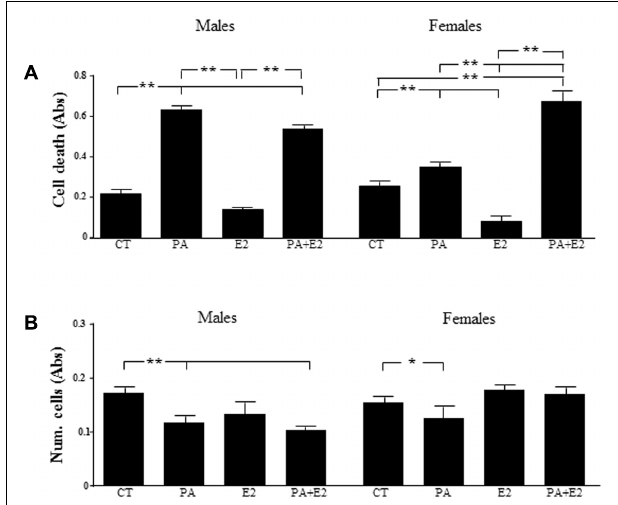
FIGURE 5 | Effects of PA and 17 β E2 on cell death and cell viability. Astrocyte cultures were treated with PA (0.5 mM), E2 (10 − 10 M) or the combination of both. Cell death was assayed by ELISA in males (A) and females (B) . Viability was assayed by crystal violet. The average of three independent assays performed in triplicate is shown. Statistical significance: ∗ p < 0.05 and ∗∗ p <